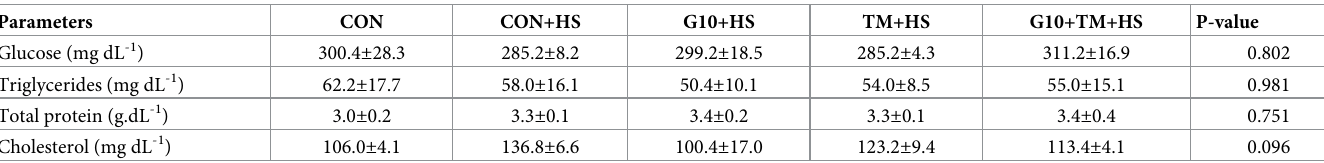
Cholesterol (mg dL -1 ) The treatments are described as follows: CON, chicks hatched from control eggs without in ovo injection and incubated at standard temperature; CON+HS, chicks hatched from control eggs without in ovo injection, incubated at standard temperature but exposed to HS; G10+HS, chicks hatched from eggs injected at 17.5 days of incubation with 0.6mL of 10% GABA dissolved in distilled water and exposed to HS; TM+HS, chicks hatched from thermally manipulated eggs exposed to 39.6˚C for 6 h daily from ED 10 to 18 and exposed to HS; G10+TM+HS, chicks hatched from eggs that received both previous treatments during incubation and exposed to HS. Data show mean ± SEM (n =